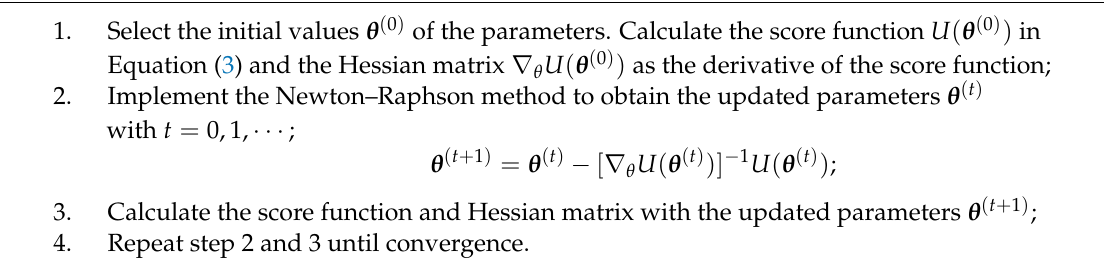
Algorithm 1: Multivariate Mixed Response Model